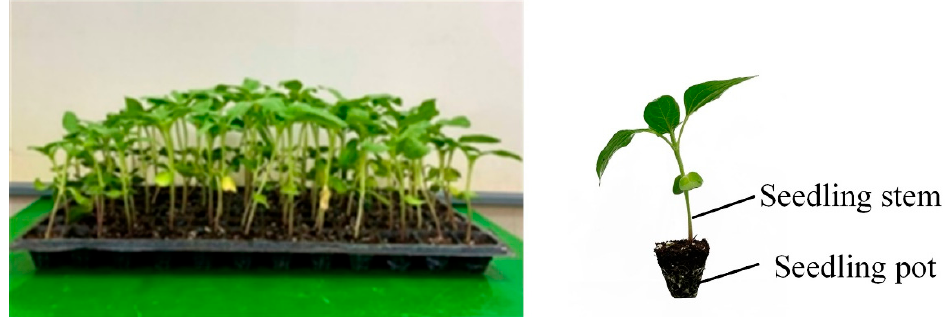
Figure 1. Oil sunflower seedlings.